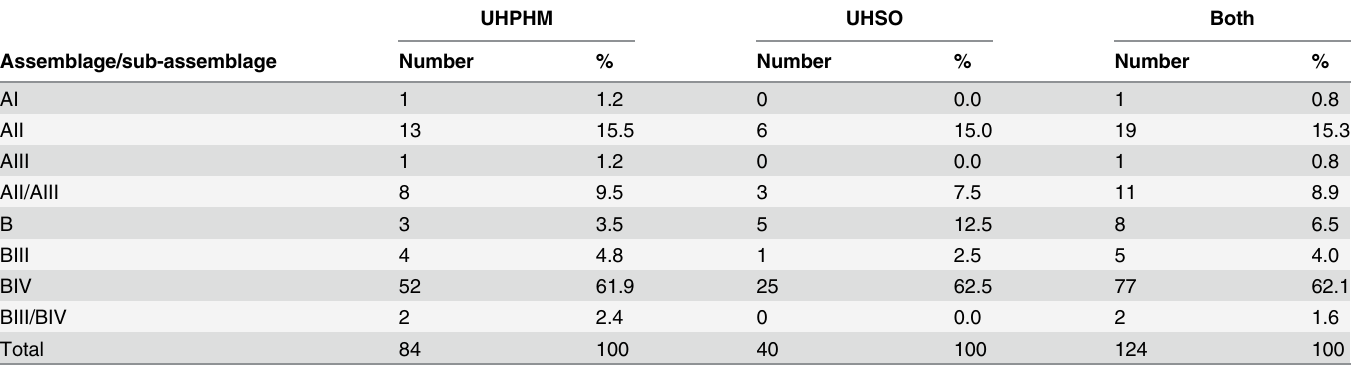
Table 3. Diversity and frequency of G . duodenalis assemblages and sub-assemblages in symptomatic individuals attended at the University Hos- pitals Puerta de Hierro Majadahonda (UHPHM) and Severo Ochoa (UHSO) in Madrid, December 2013 – January 2015.